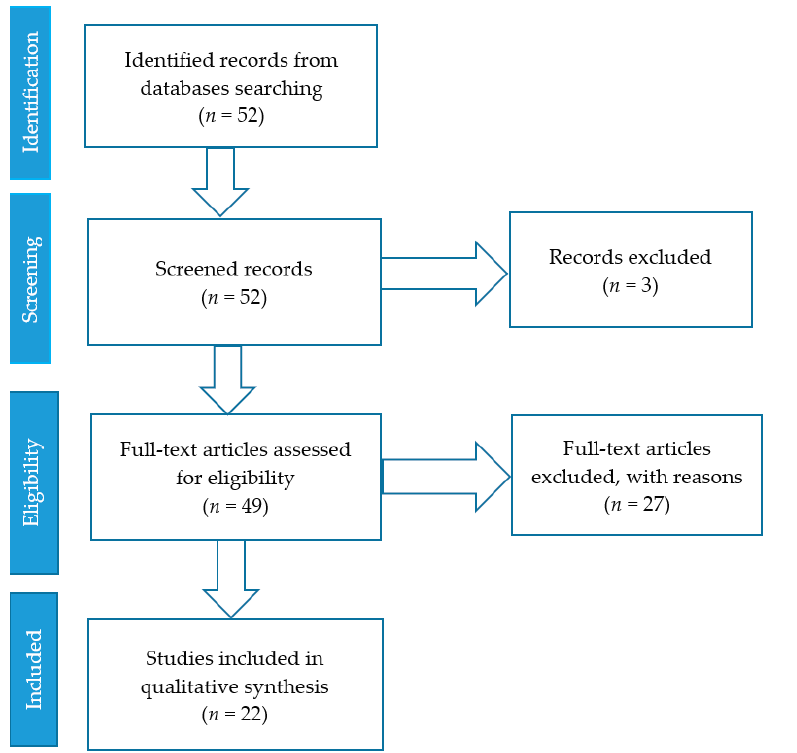
Figure 1. Flow chart of study selection process.